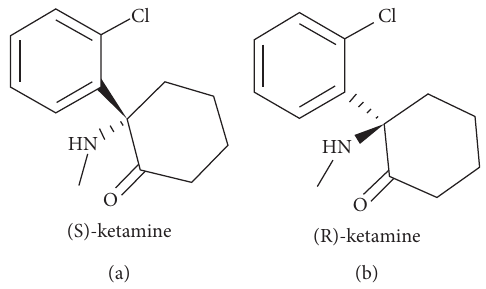
Figure 1: The structure of (a) (S)-ketamine and (b)